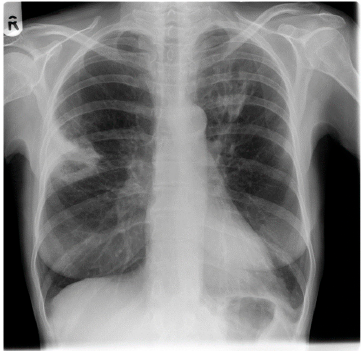
Figure 1. Chest X-ray of invasive aspergillosis in 58-year-old renal transplant recipient shows bilateral